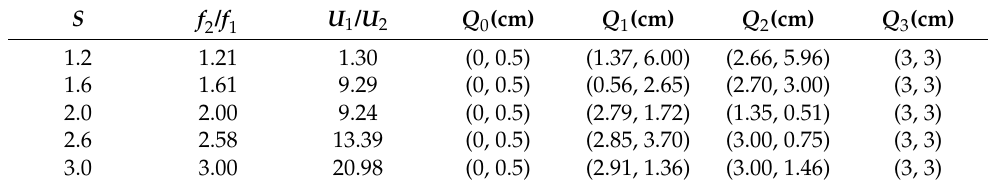
Table 1. Coordinates of the four control points ( Q 0 , Q 1 , Q 2 and Q 3 ) for various values of the specified S